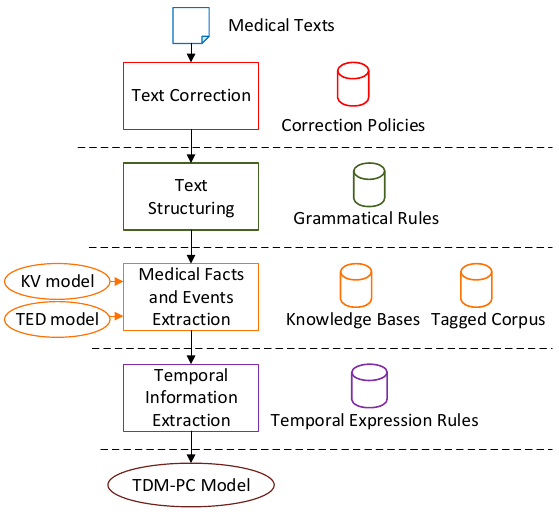
Figure 1. The architecture of MTRTI.